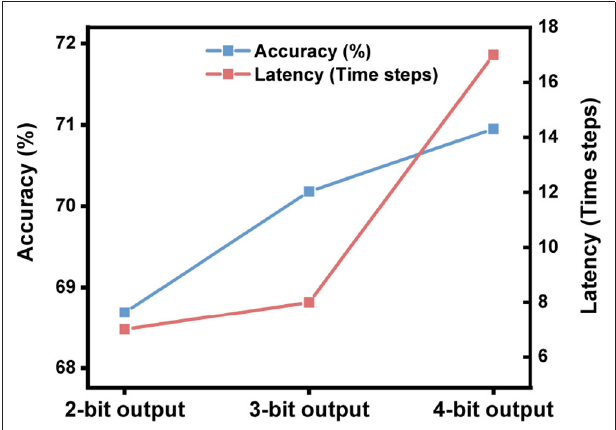
FIGURE 8 | The impact of the activation precision in the output layer during ANN quantization on the performance of SNNs on ImageNet. The network architecture is ResNet-50.